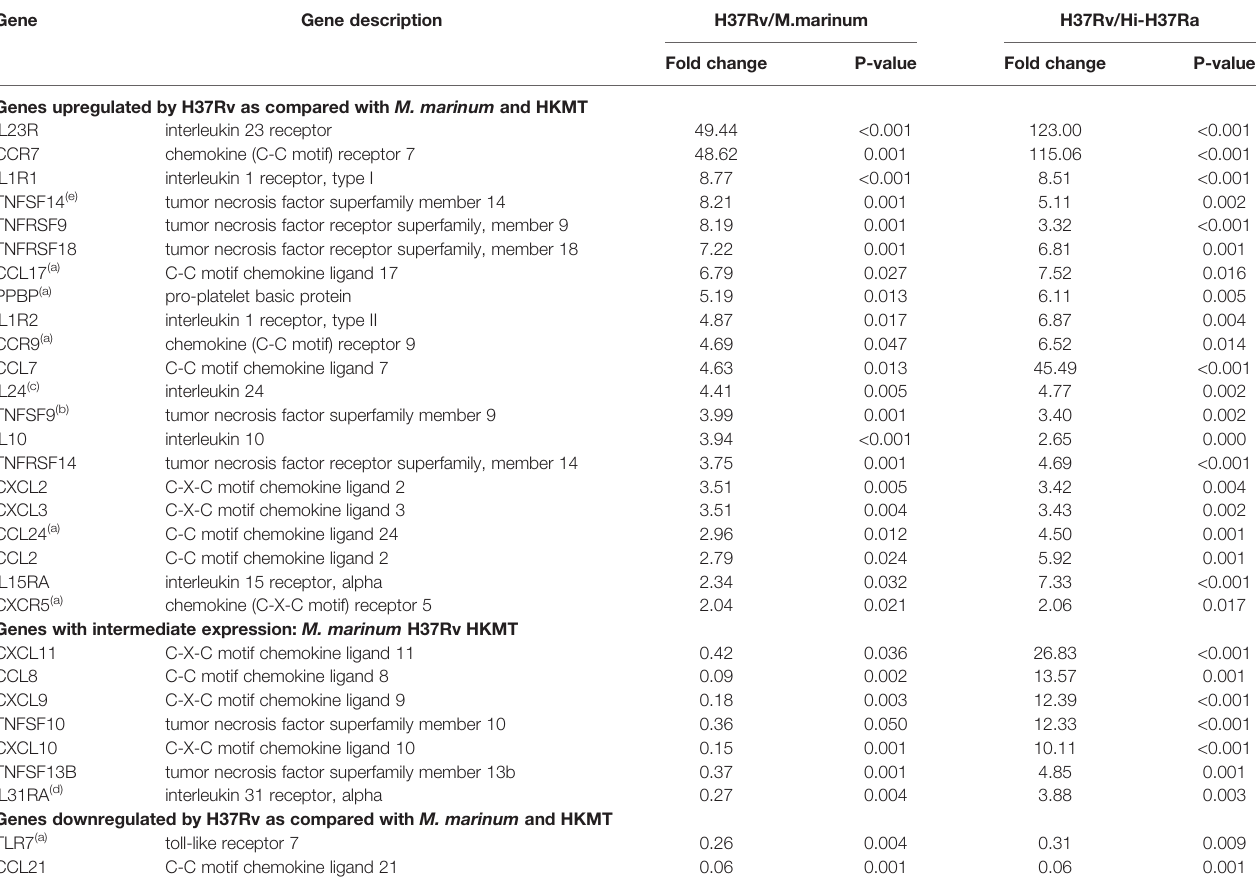
TABLE 1 | H37Rv speci fi c host response gene